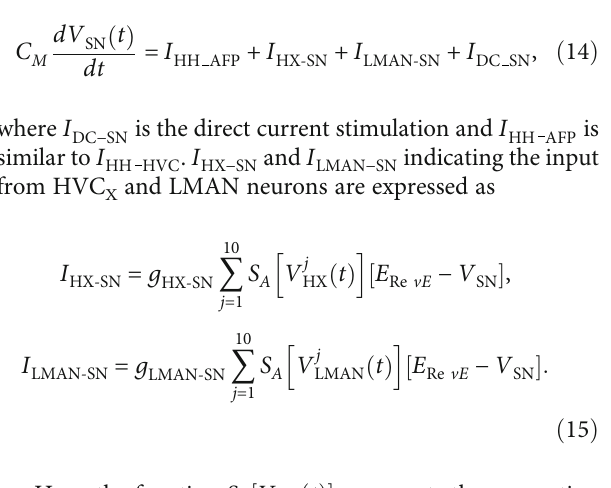
Figure 2: Neural structure of the song premotor pathway. HVC contains several types of neurons, including projection neurons (HVC ) that project to RA and area X and interneurons HVC HVC RA feed-forward model to fi re sparsely. Besides, RA has two types of neurons: inhibitory neurons and projection neurons. Inhibitory neurons are used to simulate the local inhibition phenomenon in RA, while projection neurons are stimulated by HVC and LMAN and divided into two categories. One part controls the muscle of syrinx through “ spring constant ” T ð t Þ , and the other part controls the respiratory system through driving pressure P ð t Þ . Arrow lines represent excitatory projections, while circle-headed lines represent inhibitory